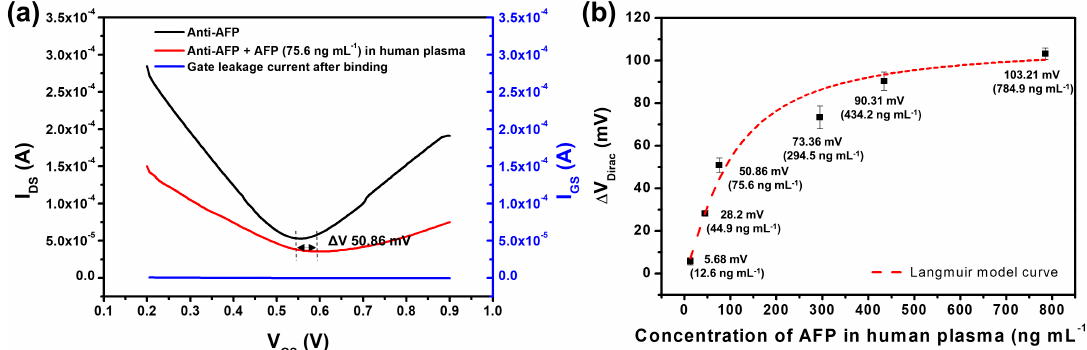
Figure 5. ( a ) the I DS -V GS characteristics of G-FET before and after binding with AFP (75.6 ng mL − 1 in human plasma of HCC patients) on the anti-AFP-immobilized channel surface; ( b ) the sensitivity of anti-AFP-immobilized G-FET for detecting AFP in human plasma from HCC patients.